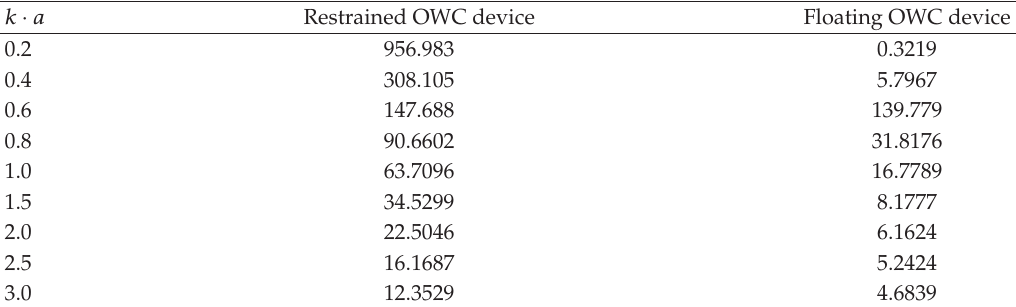
Table 5: Comparison between the maximum energy P max / (cid:4) H/ 2 (cid:5) 2 of a restrained and a floating OWC device versus ka . The mass moment of inertia I (cid:8) 1738 . 87tn · m 2 . k ·